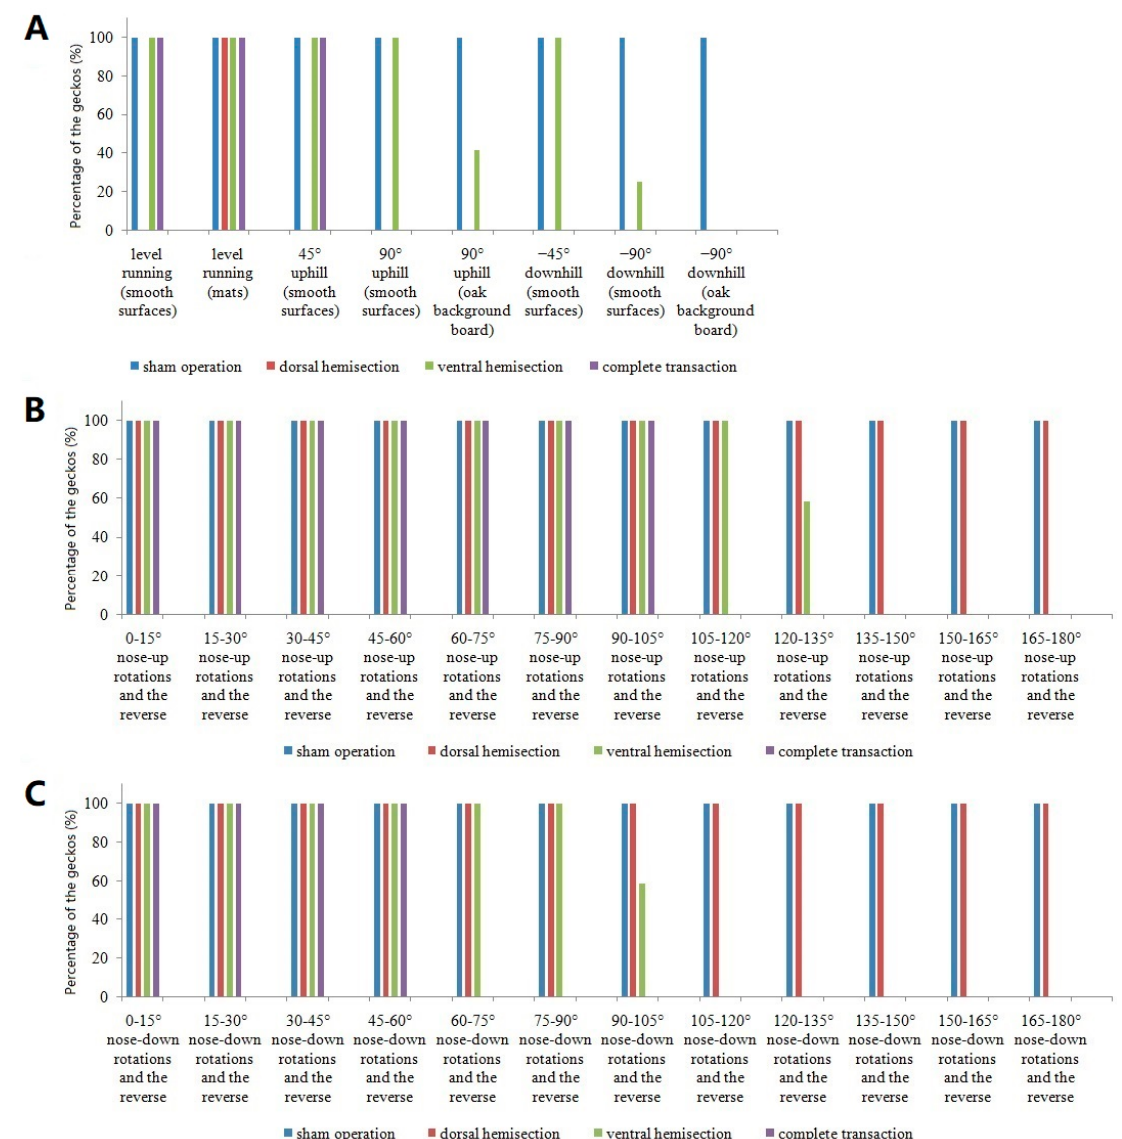
Figure 5. Comparison of persistent adhesion locomotor deficits in the geckos before (i.e., a sham operation (n = 8)) and after chronic partial (i.e., a dorsal hemisection (n = 12) or a ventral hemisection (n = 12)) or complete (i.e., complete transaction (n = 8)) spinal cord lesions. ( A ) Comparison of the percentage of the geckos (%) with 0 ◦ , +45 ◦ , − 45 ◦ , +90 ◦ , and − 90 ◦ adhesion locomotion on a flat and smooth platform, as well as the horizontal (coconut fiber) mats and the vertical oak background board in the terraria. ( B ) Comparison of the percentage of the geckos (%) tested on the platform by nose-up (turn a) rotations in steps of 15 ◦ throughout 180 ◦ . ( C ) Comparison of the number of the geckos tested on the platform by nose-down (turn b) rotations in steps of 15 ◦ throughout 180 ◦